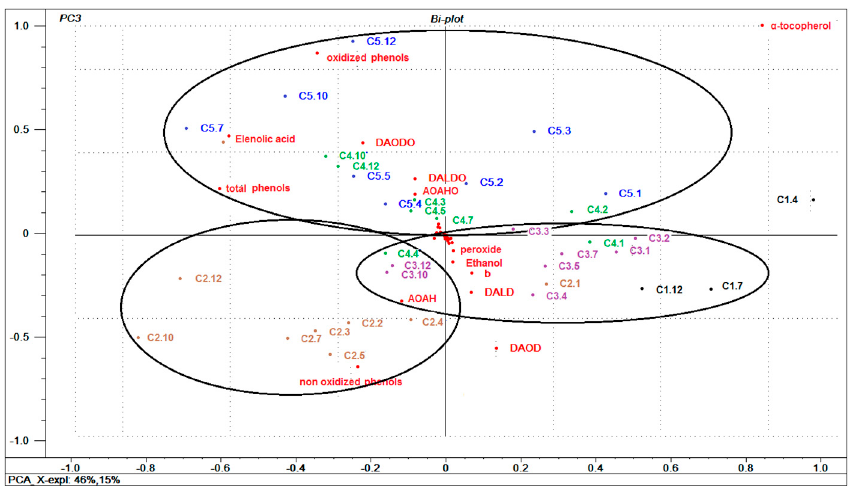
Figure 3. Multivariate general characterization of oil samples by PCA. Plots of samples and varia- bles. Sample are labeled by storage conditions (C1: stored at − 23 ± 2 °C in darkness; C2: 23 ± 2 °C, with light; C3: 23 ± 2 °C in darkness; C4: 30 ± 2 °C in darkness; C5: 40 ± 2 °C in darkness); and storage time (from 1 to 12 months). Abbreviations: AOAH: 3,4-DHPEA-EA-AH ; AOAHO: 3,4-DHPEA-EA- AH oxidized; DAOD: 3,4-DHPEA-EDA ; DAODO: 3,4-DHPEA-EDA , oxidized; DALD: p - HPEA-EDA